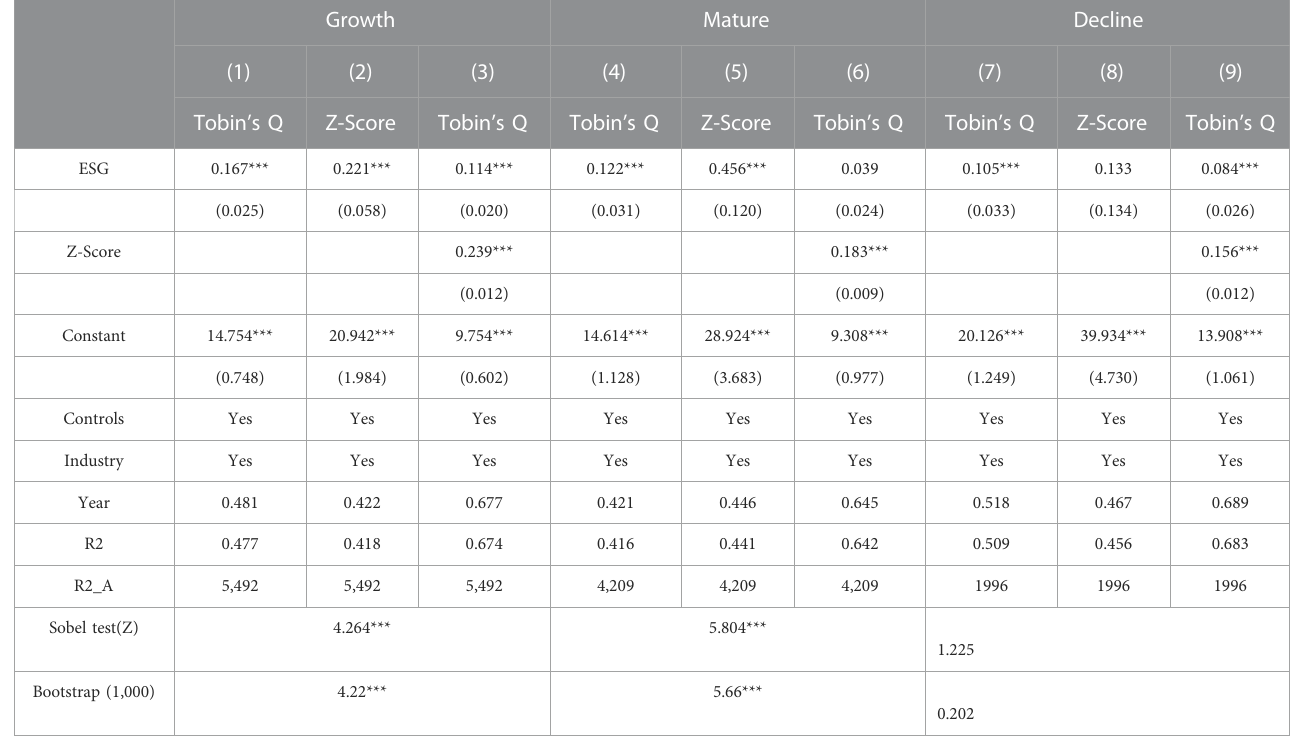
TABLE 9 The mediation effect of corporate fi nancial risk in different life cycles stages.